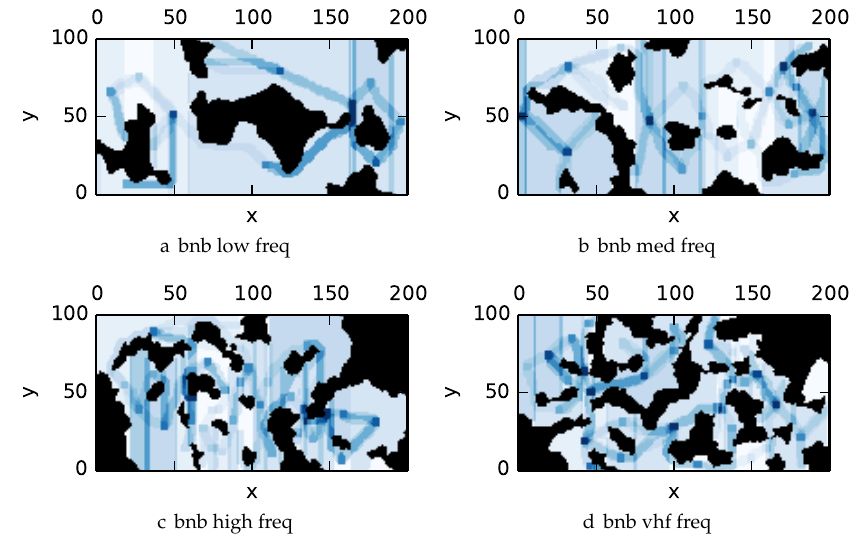
Figure 16. Multipass coverage plans in environments with nonuniform information for the (cid:101) -admissible B&B